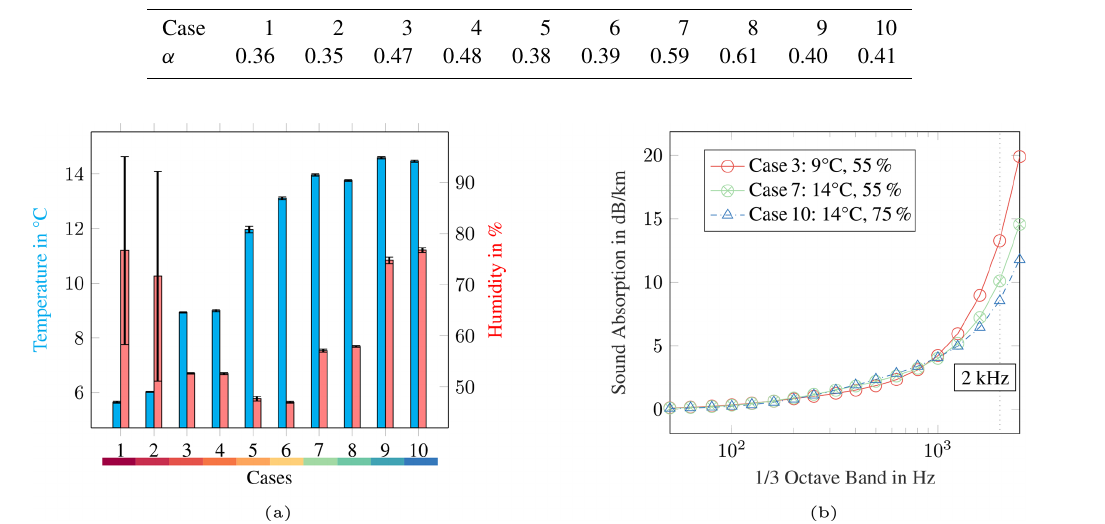
Table 4. Calculated wind shear exponent at the time of the validation cases.